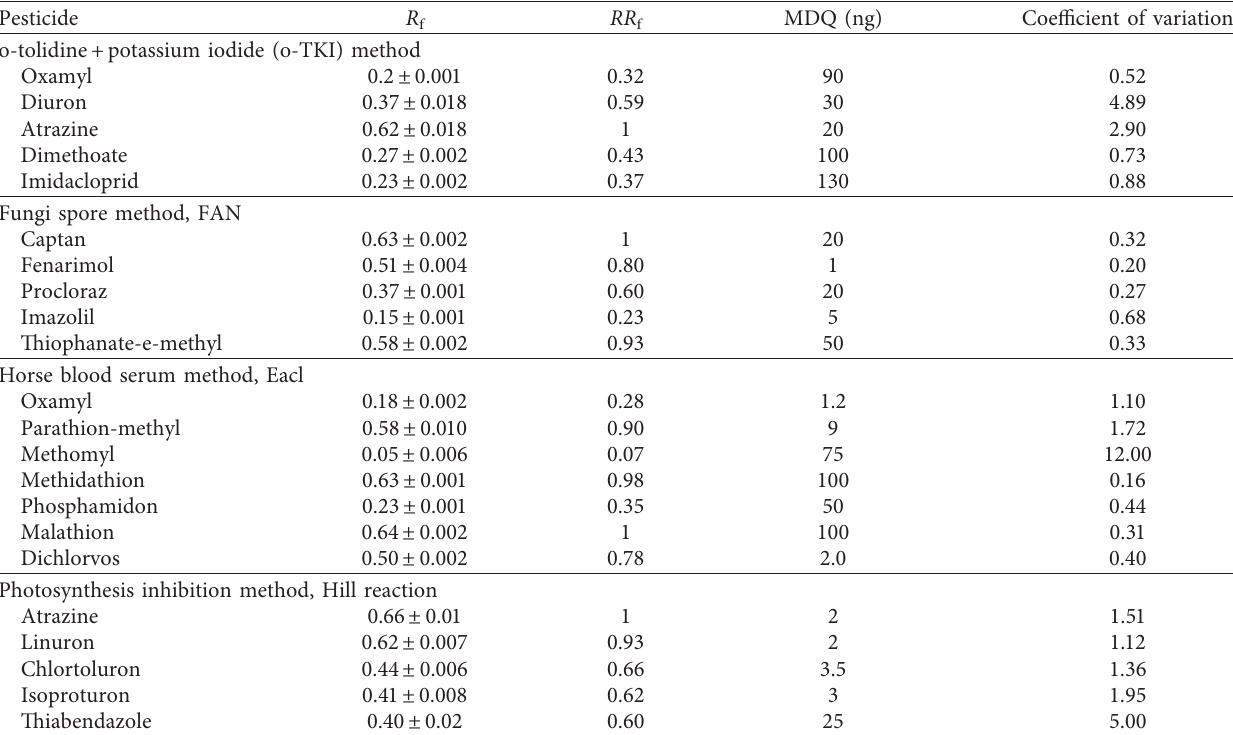
Table 1: R f and MDQ values of four TLC validation